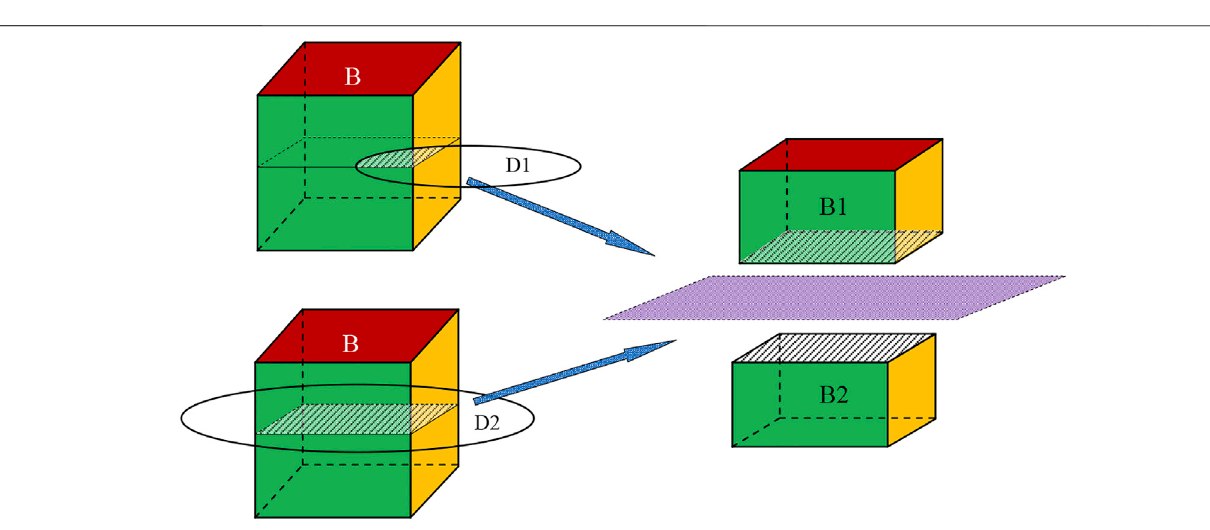
FIGURE 6 | The discontinuity cut polyhedron.